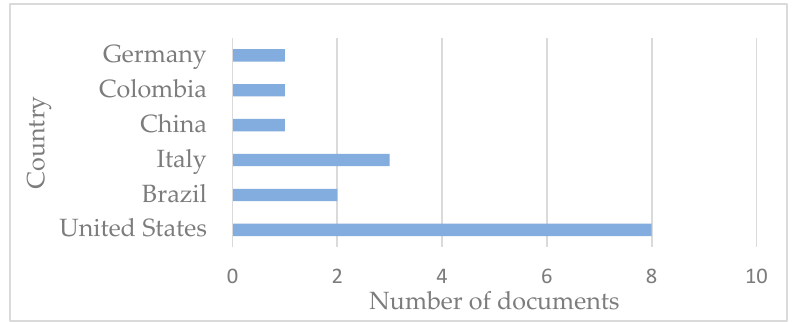
Figure 4. Number of documents by country.